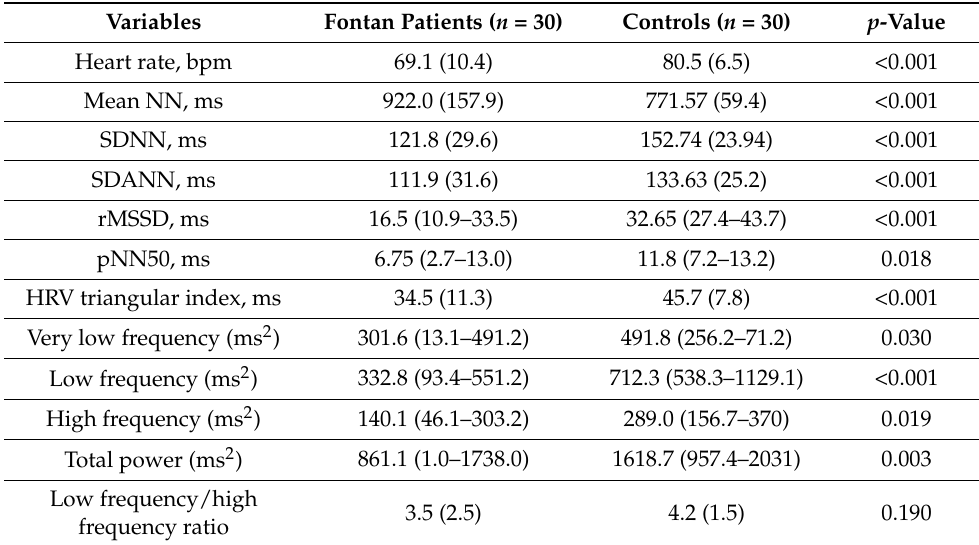
Table 5. Heart rate and HRV in the Fontan patients and control